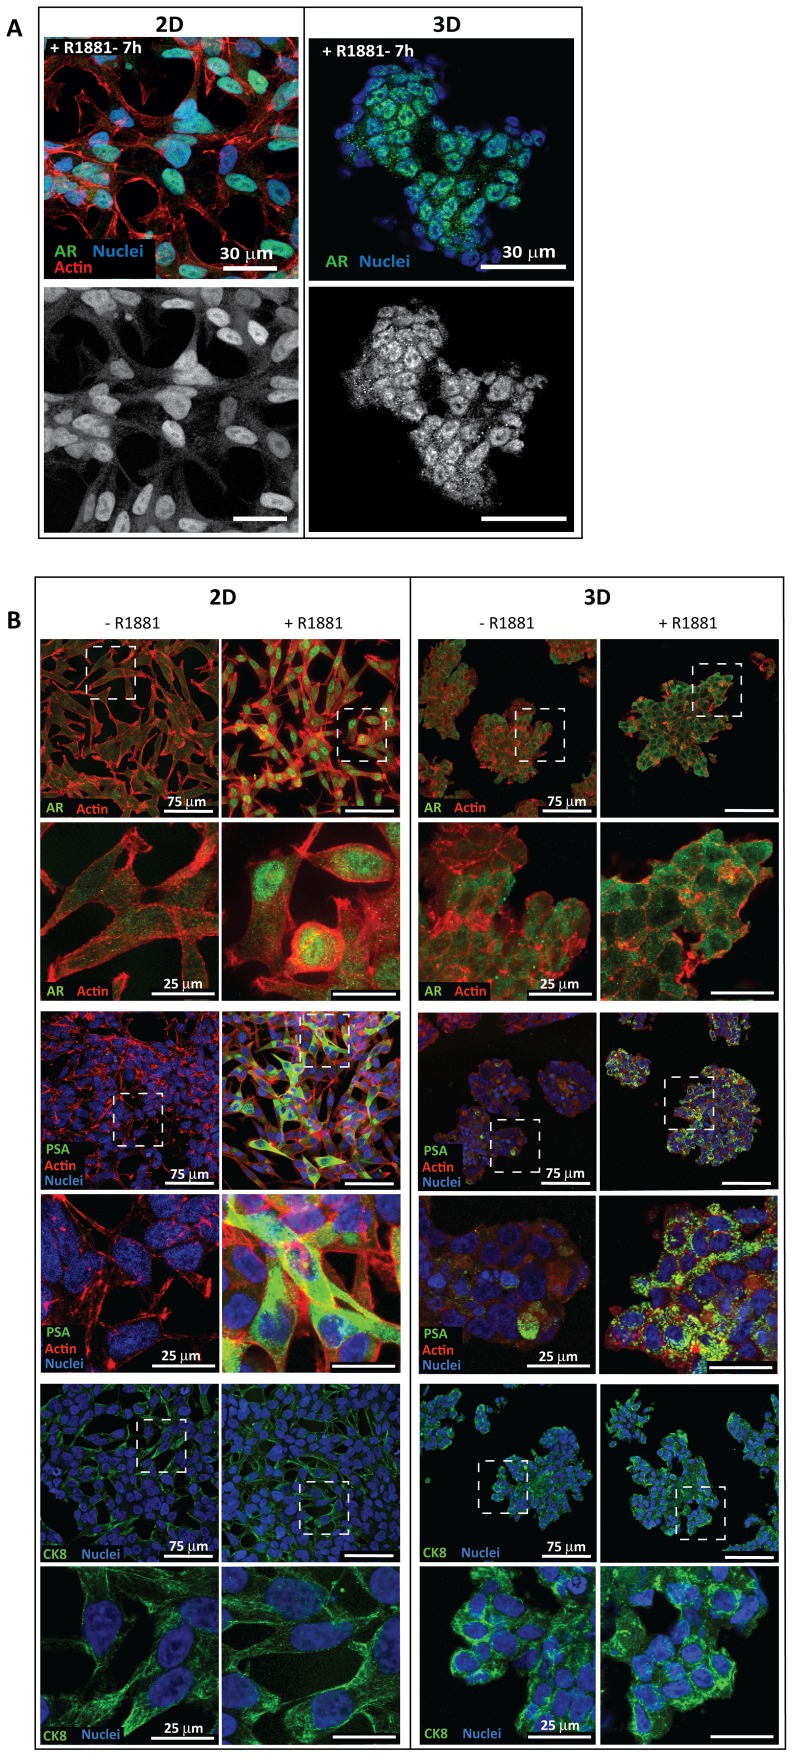
Phenotypic comparison of LNCaP cells in response to 1 nM R1881 in 2D and 3D cultures.(A) Immunofluorescent stainings of LNCaP cells after 7 h treatment with R1881 show co-localization of the AR and cell nucleus in both 2D (day 6) and 3D (day 28) cultures (top panel). Corresponding AR localization in both cultures is shown in grayscale images (bottom panel). (B) The cell phenotypes of 2D (day 6, left panel) and 3D (day 28, right panel) cultures grown in androgen depleted media or R1881 supplemented media (48 h) were compared by immunofluorescent stainings. Proteins of interest are in green, actin in red and nucleus in blue. In 2D cultures, AR is localized in the nucleus and PSA in the cytoplasm upon R1881 stimulation. Without treatment, the AR remains in the cytoplasm and PSA is not detected. The luminal epithelial marker, CK8 is detected in both cultures regardless of treatment condition. In 2D cultures, CK8 clearly stains the filament fibers while in 3D, CK8 is localized at the cell border. In 3D cultures, extranuclear AR localization is observed in both non treated and R1881 treated multicellular aggregates. PSA is also produced abundantly in R1881 treated 3D cultures but only at a very low level when not treated. Magnified regions of each specific staining and culture condition (white boxes) are shown below the corresponding images. CLSM images were taken at 60× magnification (1.4 NA) for A and 40× magnification (1.25 NA) for B. Scale bars: (A) 30 µm, (B) 75 µm and 25 µm (magnified regions).